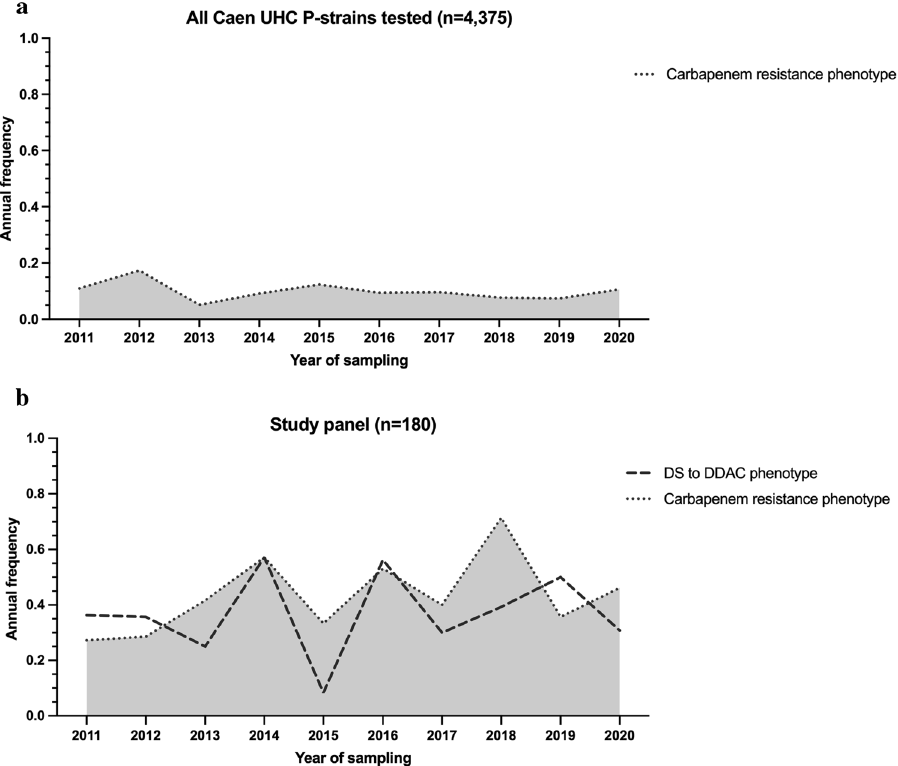
Figure 3. Annual frequency of carbapenem (imipenem and/or meropenem) resistance phenotype for: ( a ) P. aeruginosa P strains tested for antibiotic susceptibility at the University Hospital of Caen (n = 4375) and ( b ) the study panel n = 180 (decreased susceptibility to DDAC is